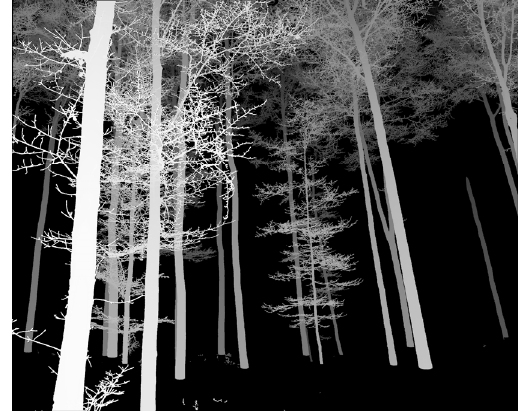
Figure 8. 2D range image after automatic removal of the ground points (range up to 30